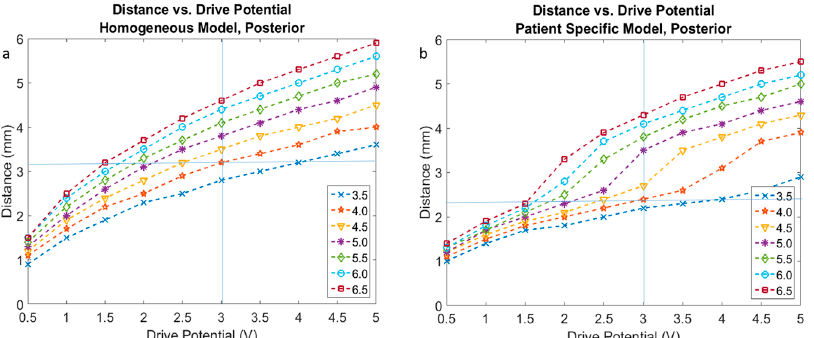
Figure 4. Activation distance plots based on FEM analysis for voltage driven lead 3389 with fixed parameters of 60 µs pulse width, drive potentials range of 0.5 to 5 V, and neuron diameters ranging from 3.5 µm to 6.5 µm. ( a ) Homogeneous tissue model and ( b ) patient-specific tissue model.